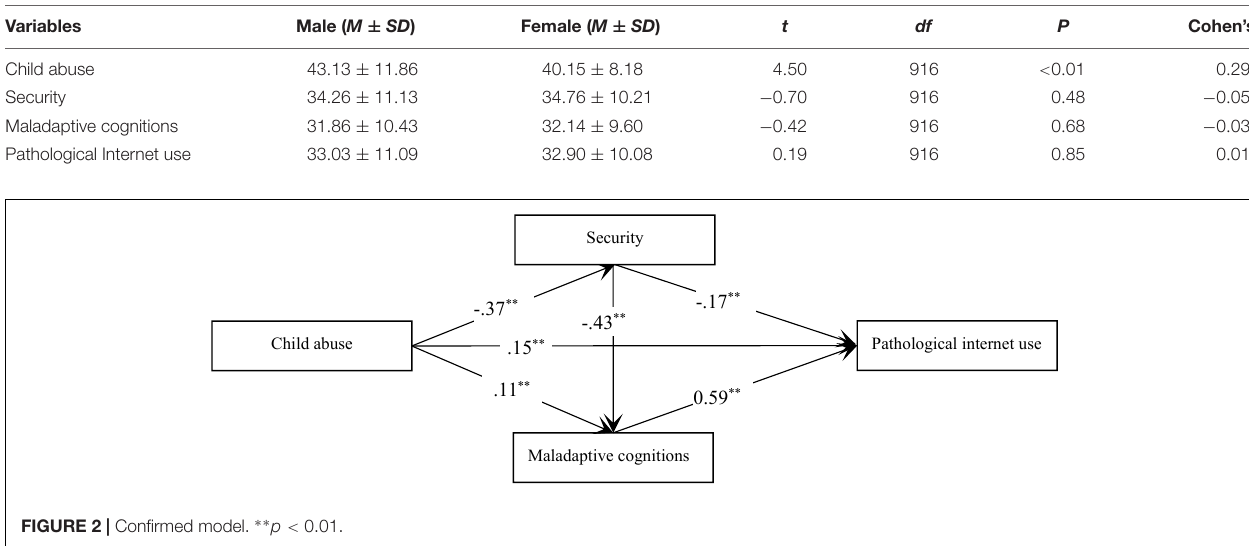
TABLE 2 | Gender difference test of variables.